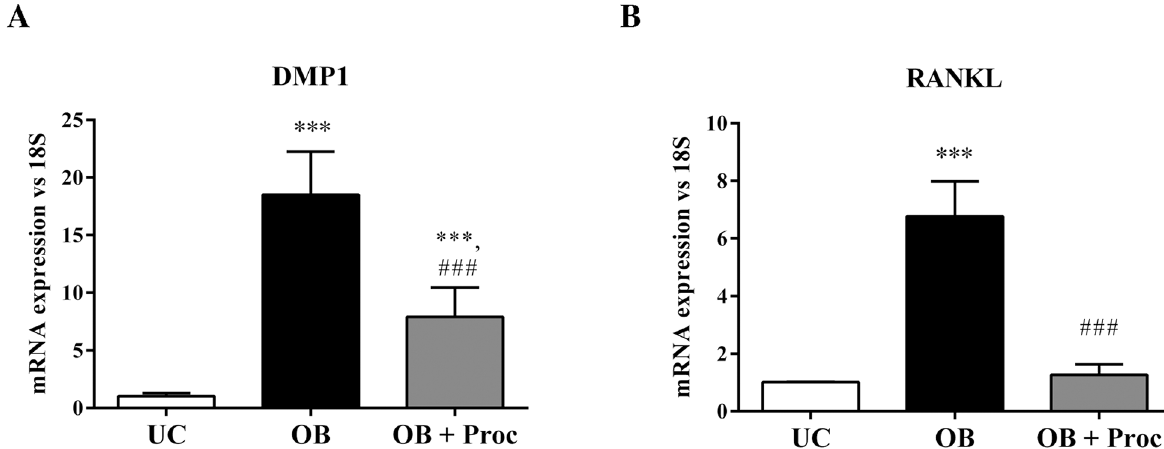
Fig 2. Procaine impairs osteogenic maturation of mesenchymal stem cells (MSC). mRNA expression of mature markers of oste/ odontoblast such as A) DMP1 and B) RANKL were measured by RT-PCR after 21 days in culture. The expression in mesenchymal stem cell differentiated into osteo/odontoblasts (OB) was significantly higher than in undifferentiated cells (UC). This expression was reduced by the addition of Procaine (OB+Proc) during the differentiation process. Ribosomal 18S expression was used as housekeeping ( * p < 0.05 vs all groups).